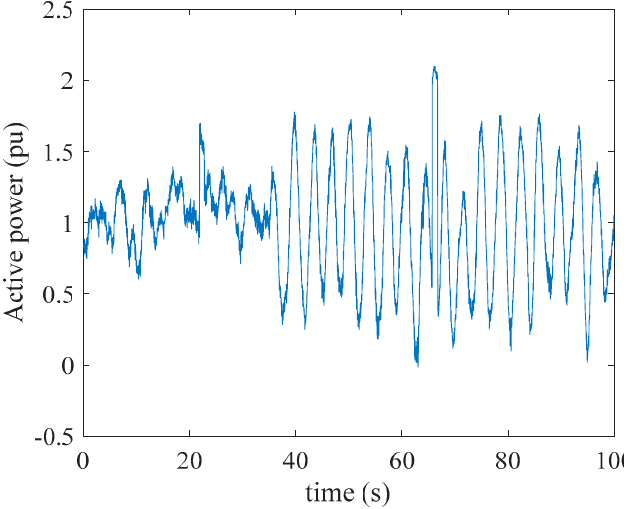
Figure 7. Forced oscillations with the frequency of 0.27 Hz in ISO New England, which are successfully identified as forced oscillations by the proposed method.